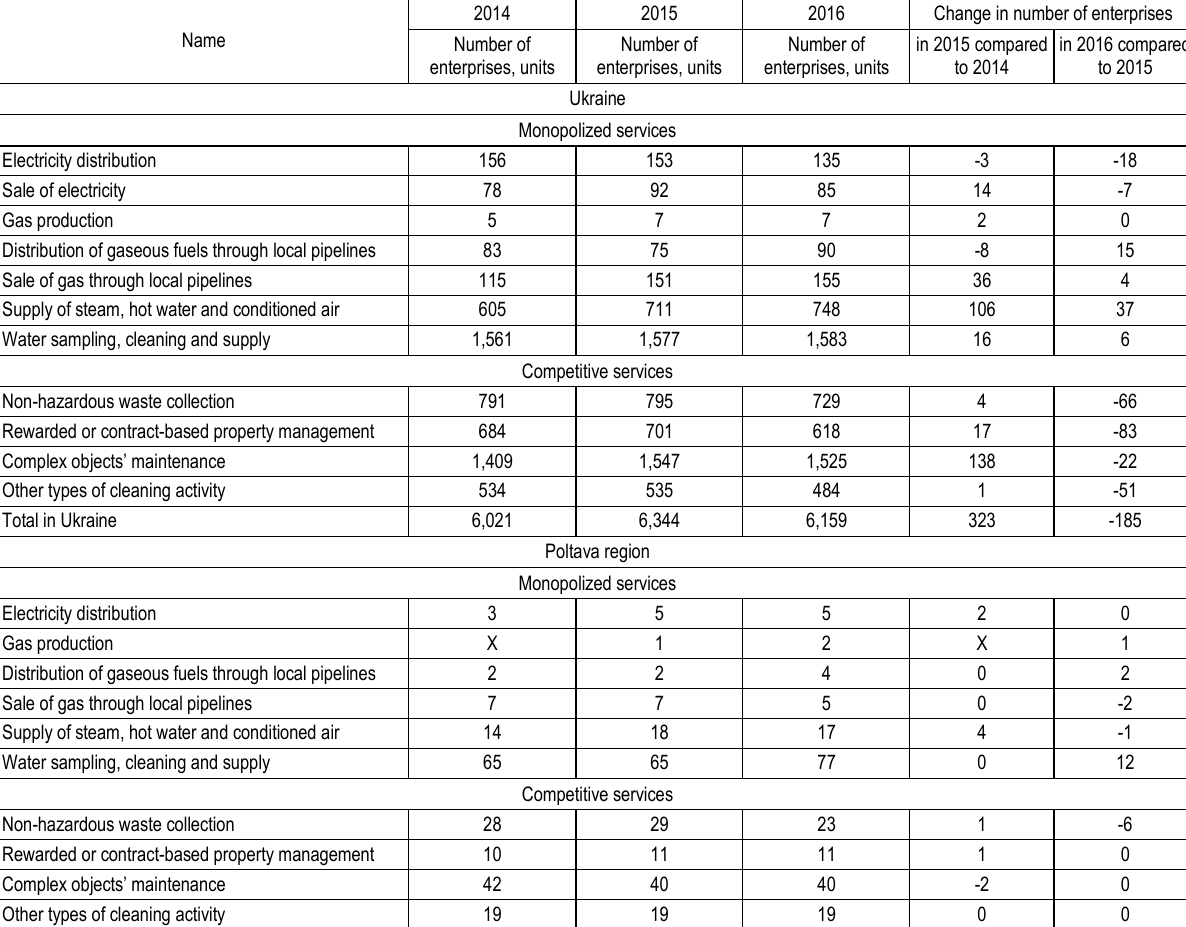
Table 1. Increase in the number of Ukrainian housing and utility services enterprises according to the types of services in the period